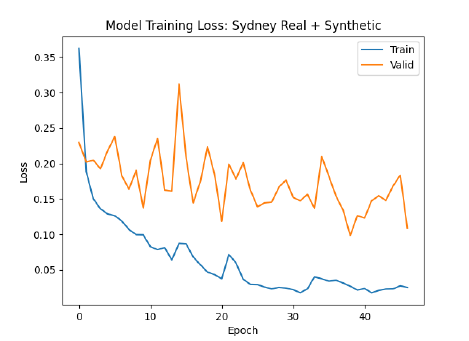
Figure 9. Training curves for the model trained with real+synthetic samples